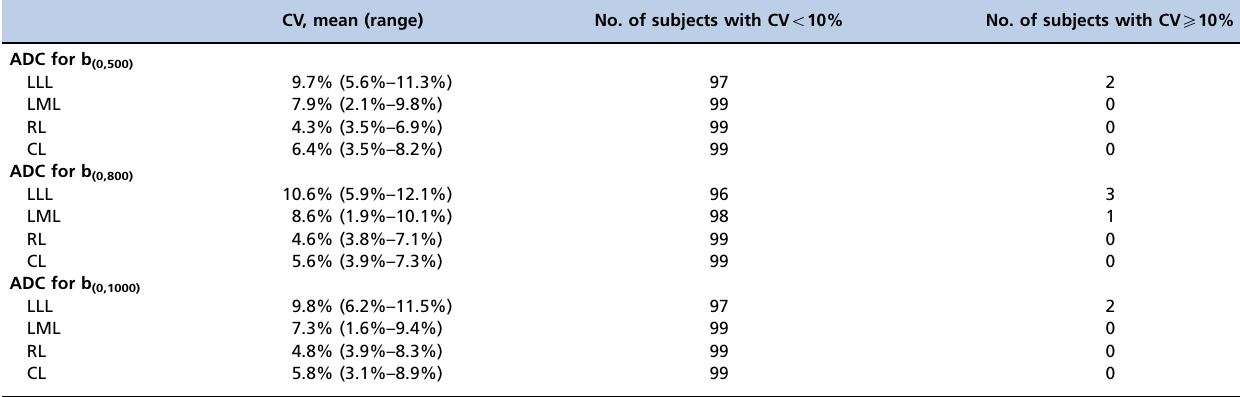
Table 1 - Reproducibility of the apparent diffusion coefficient ( (cid:1) 10 -3 mm 2 /s) measurements in the enrolled participants. CV, mean (range) No. of subjects with CV o 10%